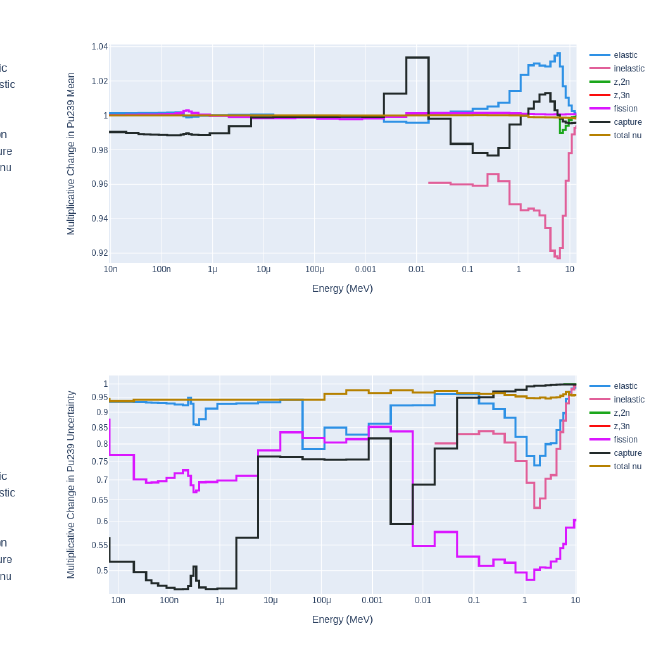
Figure 6. The same as Fig. 5 except for adjustment to selected PU-MET-FAST, PU-MET-INT and PU-MET-SOL k e ff values.